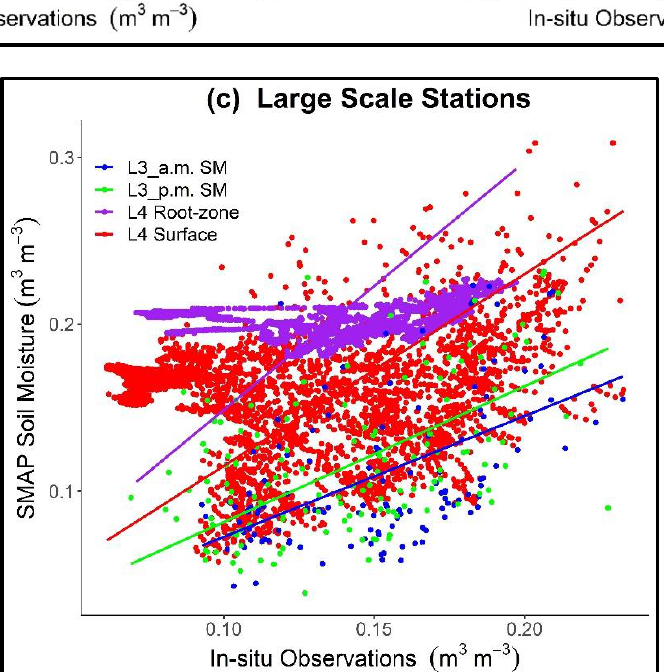
Figure 12. Scatter plots between estimated SM from SMAP products (SPL3SMP_E and SPL4SMGP) and in situ data observed from SMN-SDR for ( a ) S-scale, ( b ) M-scale, ( c ) L-scale.